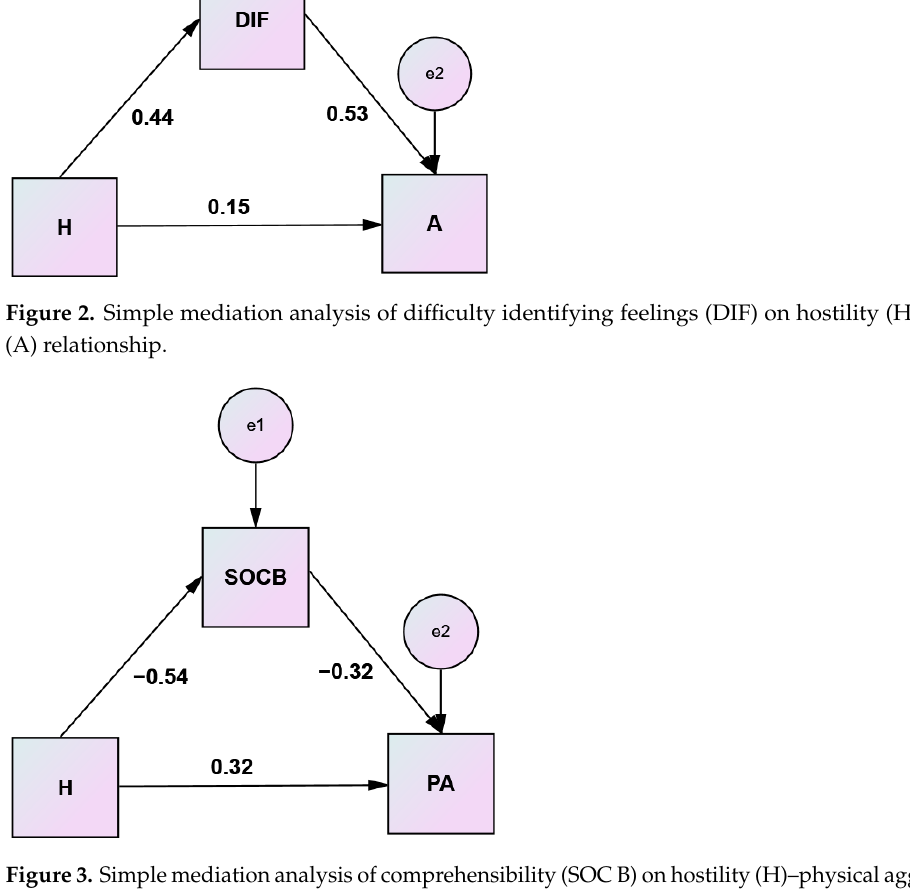
Figure 4. Simple mediation analysis of manageability (SOC C) on anger (A)–physical aggression (PA) relationship.